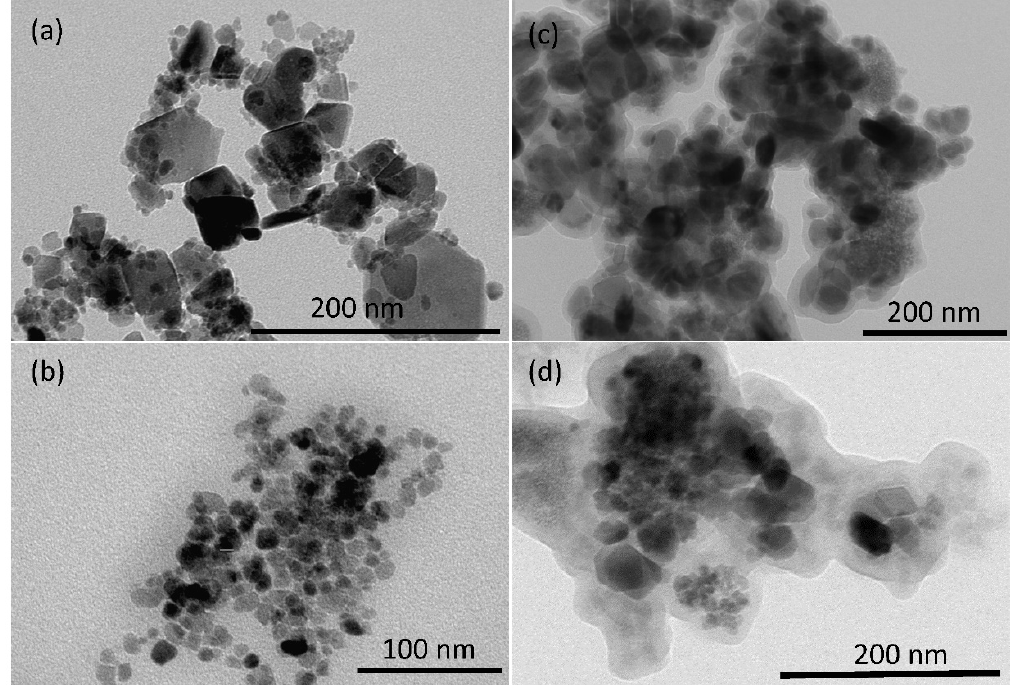
Figure 2. Transmission electron microscopy (TEM) images of MNP 30 ( a ), MNP 11 ( b ), MNP 30 -Si ( c ) and MNP 30 -Si us ( d ) materials.